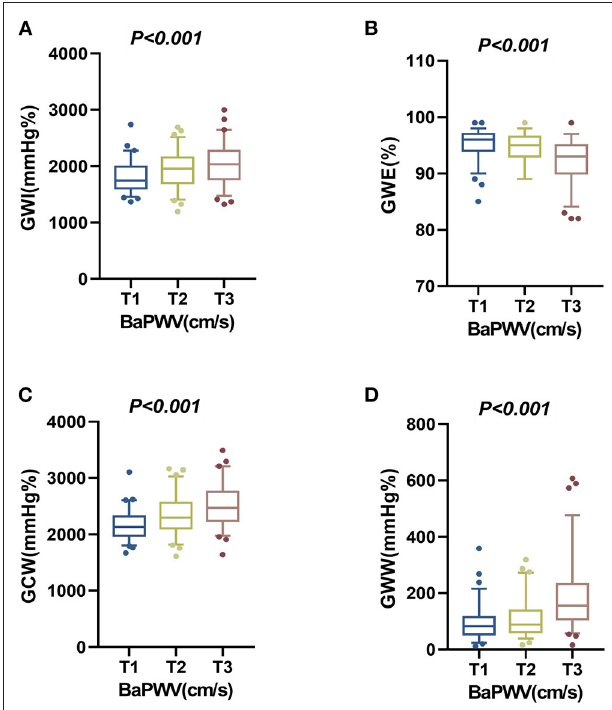
FIGURE 3 | The distributions of the four components of MW among the baPWV tertile groups in the overall population. (A) The distribution of GWI in the baPWV tertile groups. (B) The distribution of GWE in the baPWV tertile groups. (C) The distribution of GCW in the baPWV tertile groups. (D) The distribution of GWW in the baPWV tertile groups. baPWV, brachial-ankle pulse wave velocity; GCW, global constructed work; GWE, global work efficiency; GWI, global work index; GWW, global wasted work; MW, myocardial work.